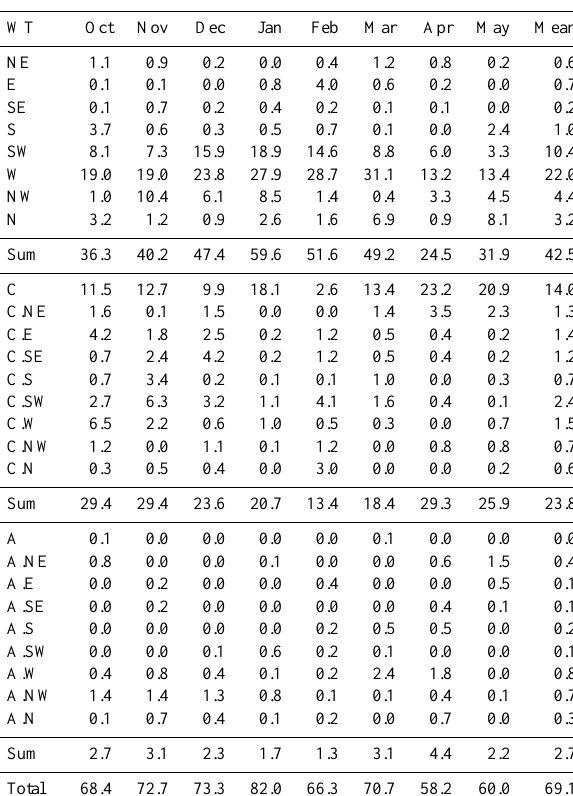
Table 2. Average estimated WT percentage contribution to total monthly Iberian precipitation during